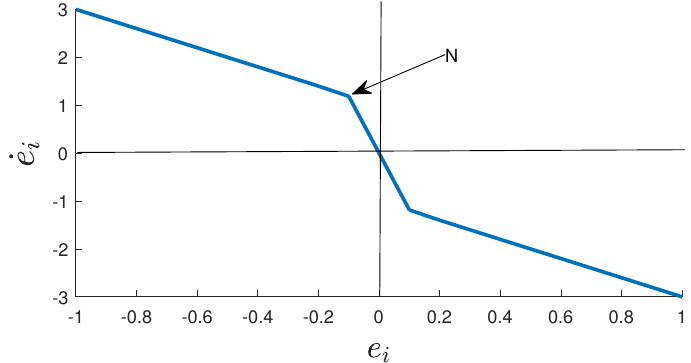
Figure 3. The proposed modified sigmoid sliding